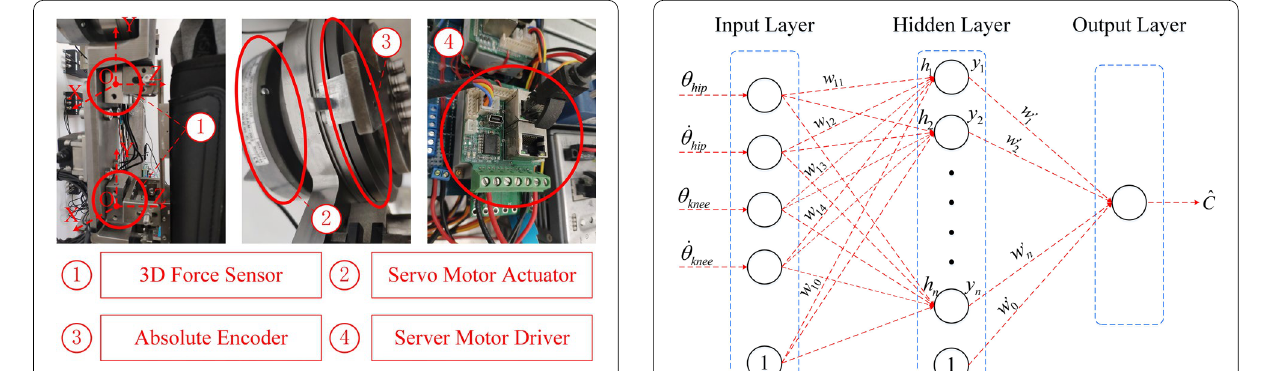
Figure 4 Sensors, actuators, and drivers are used in the exoskeleton electronic system Figure 5 BP neural network structure is used for the human-robot interaction force